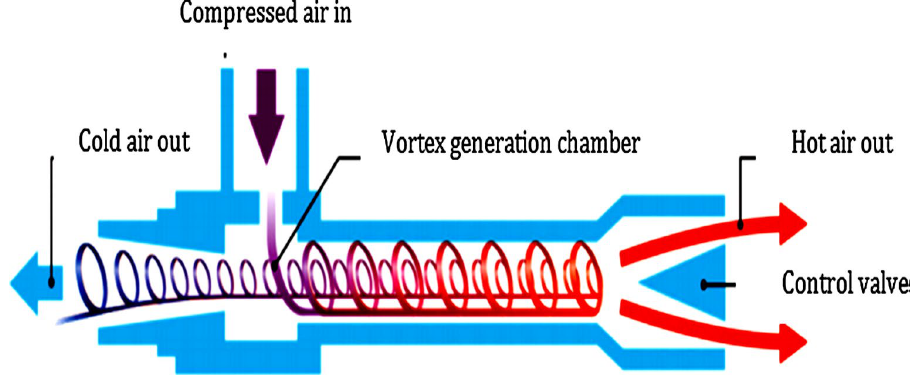
Figure 2. Generating of cold air employing RHVT